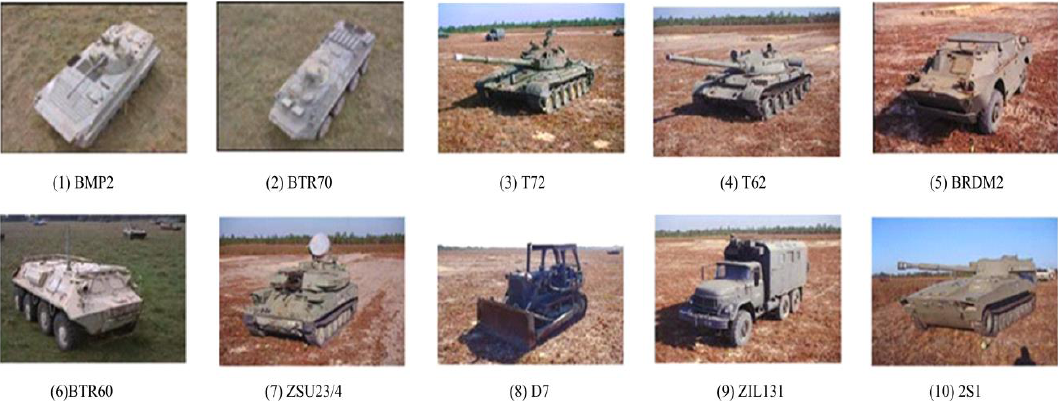
Figure 8. Optic images of the ten targets to be classified.